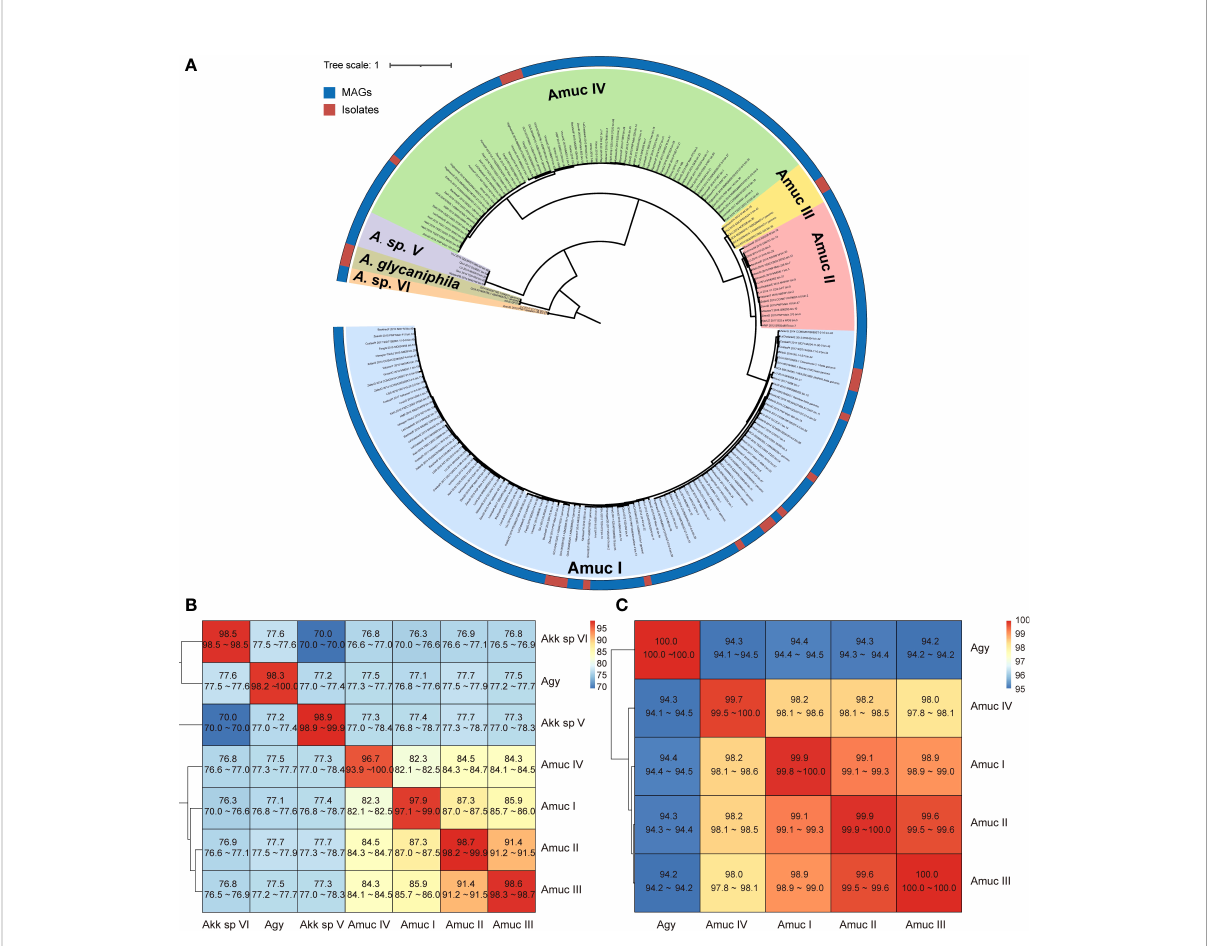
FIGURE 2 Phylogenetic analysis of Akkermansia genomes. (A) Phylogenetic tree of 1,126 MAG and 85 isolated genomes. Filling colors in the phylogenetic tree represent different species or phylogroups. The outer circle represents the original strains from MAGs and isolated genomes. For better visualization, only 10% of the strains of Amuc I and Amuc II were used, without changing the overall structure of the tree. (B, C) Heatmaps show the pairwise ANI among seven Akkermansia species and phylogroups (B) and the 16S sequence similarity among fi ve Akkermansia muciniphila phylogroups and Akkermansia glycaniphila (C)